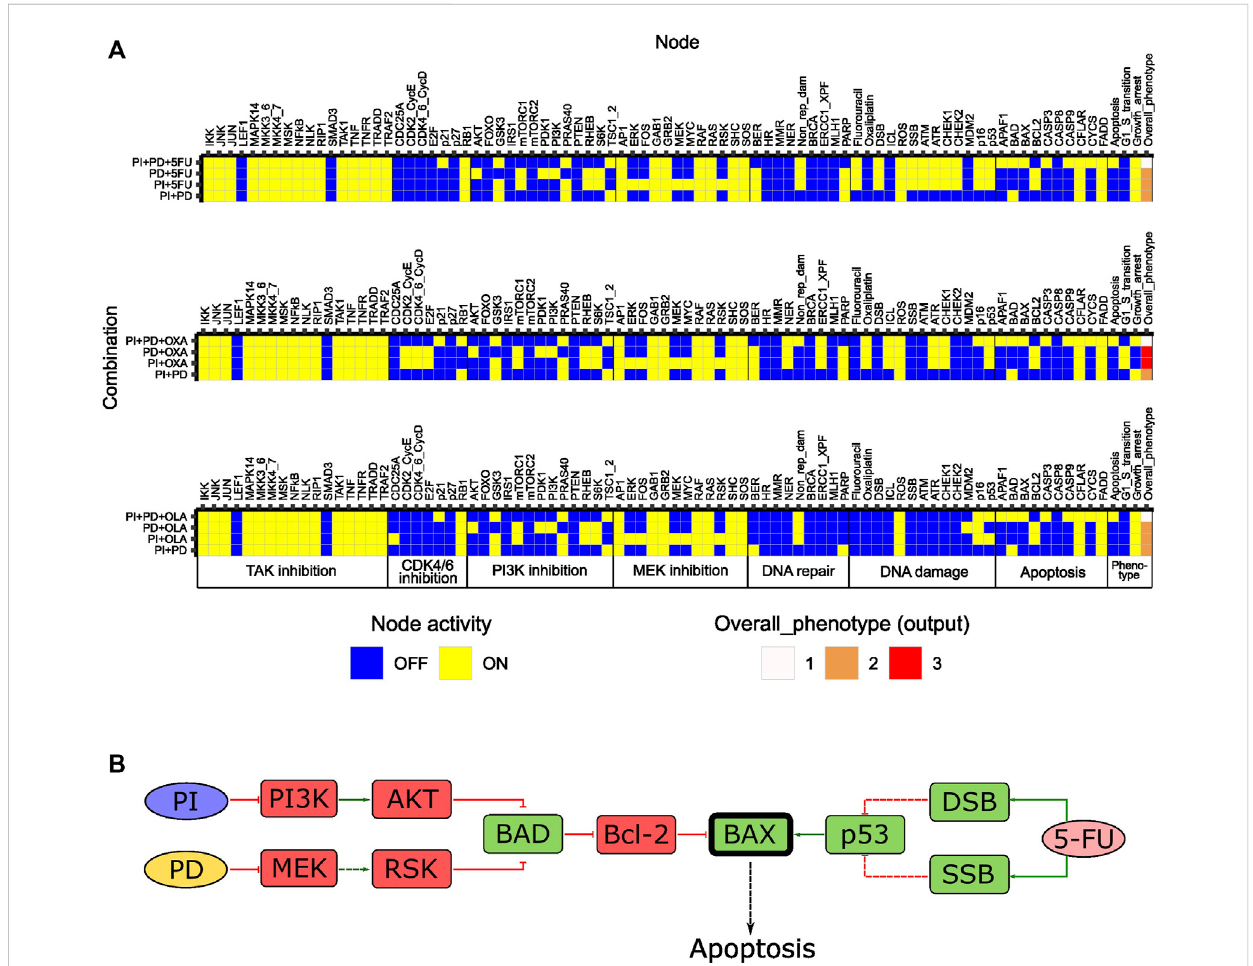
FIGURE 5 In silico effects of third-order drug combinations predicted for HCT-116 cells. (A) Stable states (row-wise) computed with the adjusted model for synergistic third-order drug combinations and associated second-order combinations. The probability for the stable state of the third-order drug combinationwas1inallthreecases. (B) Suggestedmechanismaccountingforthesynergisticeffectsofthird-ordercombinationsin (A) ,exempli fi edforPI + PD+5FU. Synergistically activated BAX is highlighted in bold. Dashed arrows/bar-headed lines indicate indirect links between